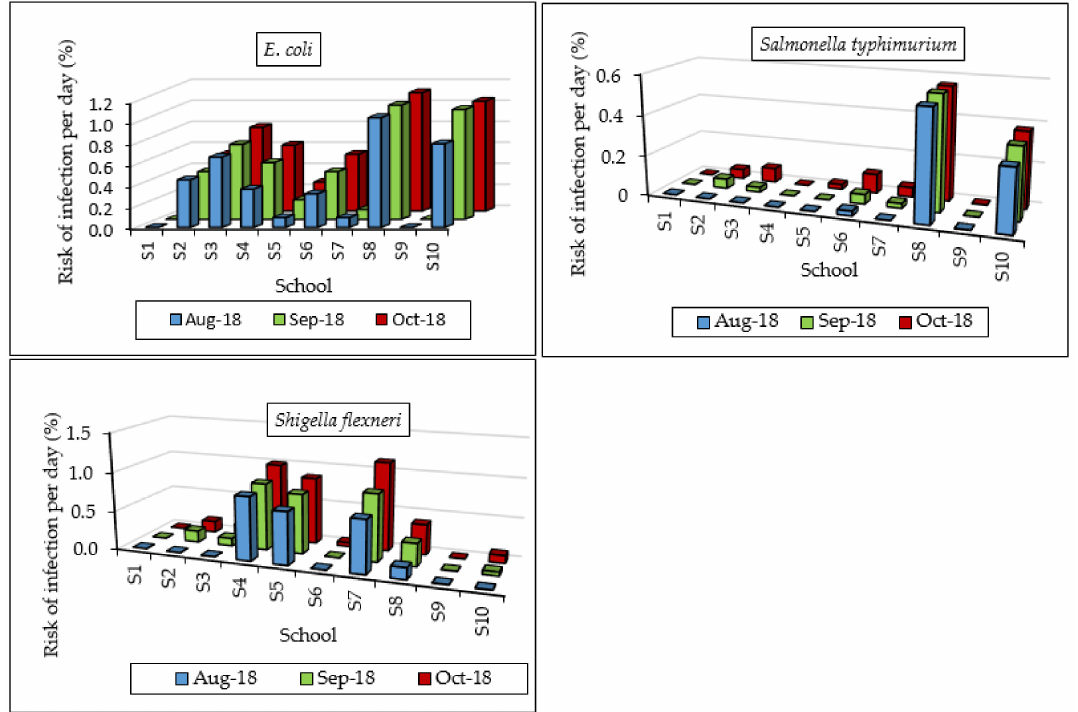
Figure 6. Risk of infection per